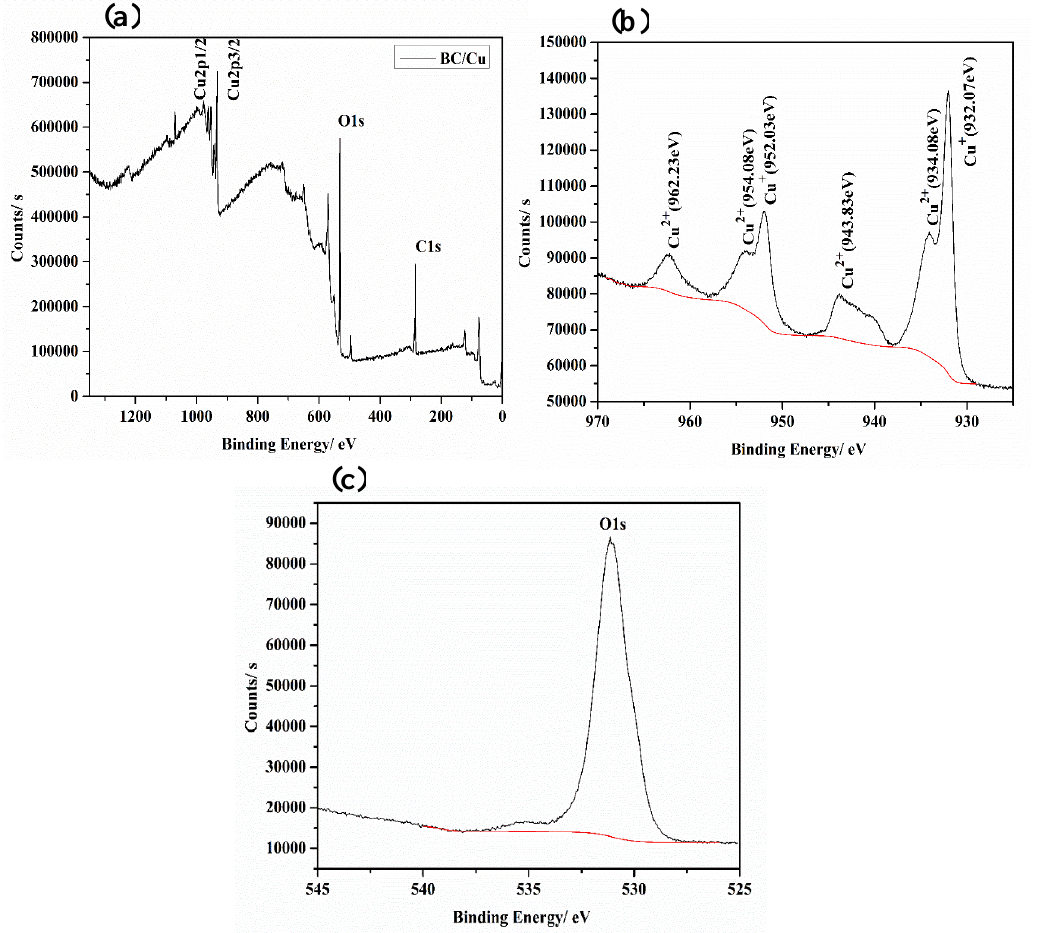
Figure 3. XPS peak representations of bacterial cellulose / copper nanocomposite: ( a ) XPS full spectrum; ( b ) copper peaks; ( c ) oxygen peak.